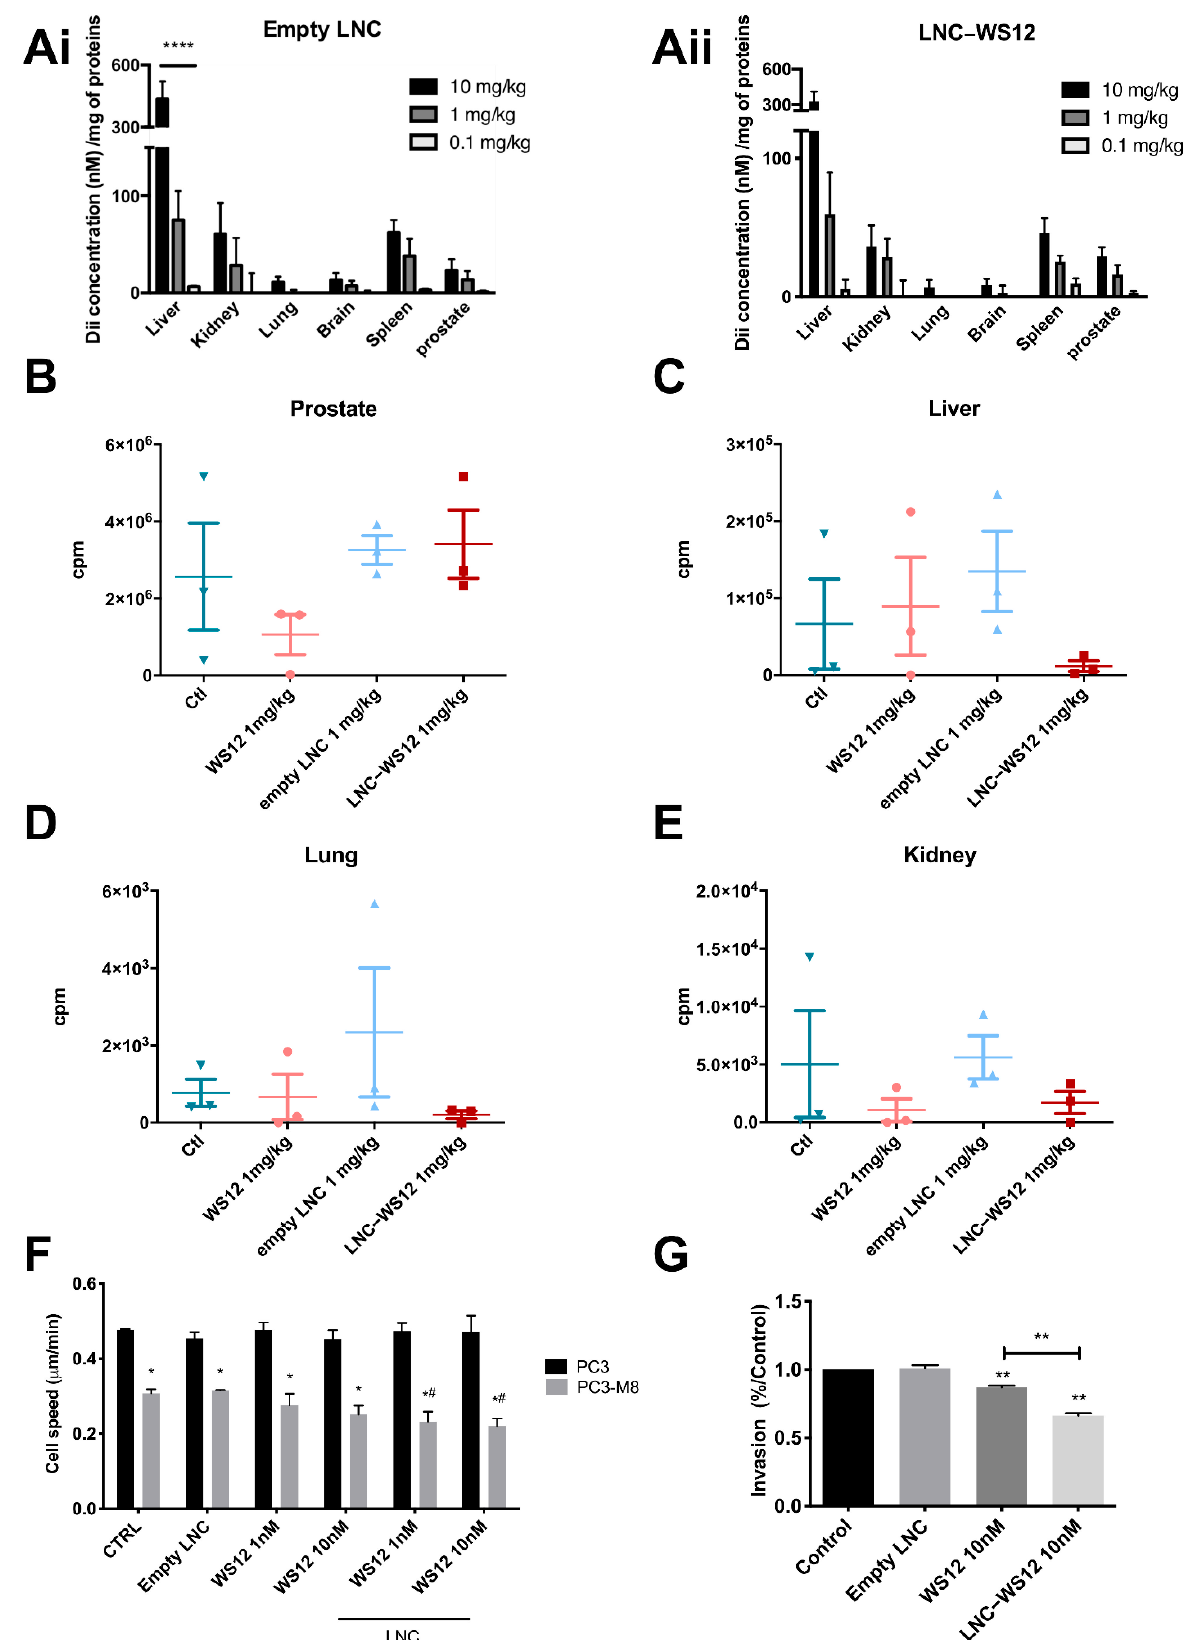
Figure 6. Effects of lipid nanocapsules (LNC) containing a TRPM8 agonist on migratory and invasive properties. ( A ) Biodistribution of empty LNC ( Ai ) and LNC WS–12 ( Aii ) labeled with DiI in